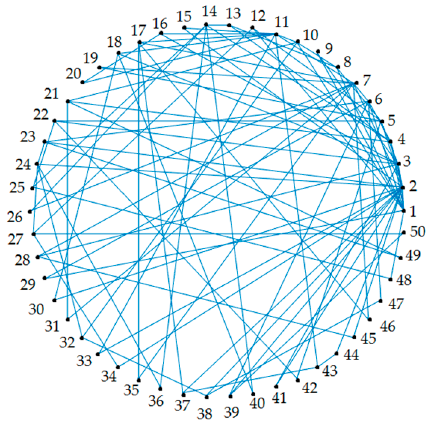
Figure 14. Fifty-node network used in simulations. Figure 14. Fifty ‐ node network used in simulations. Figure 14. Fifty ‐ node network used in simulations.